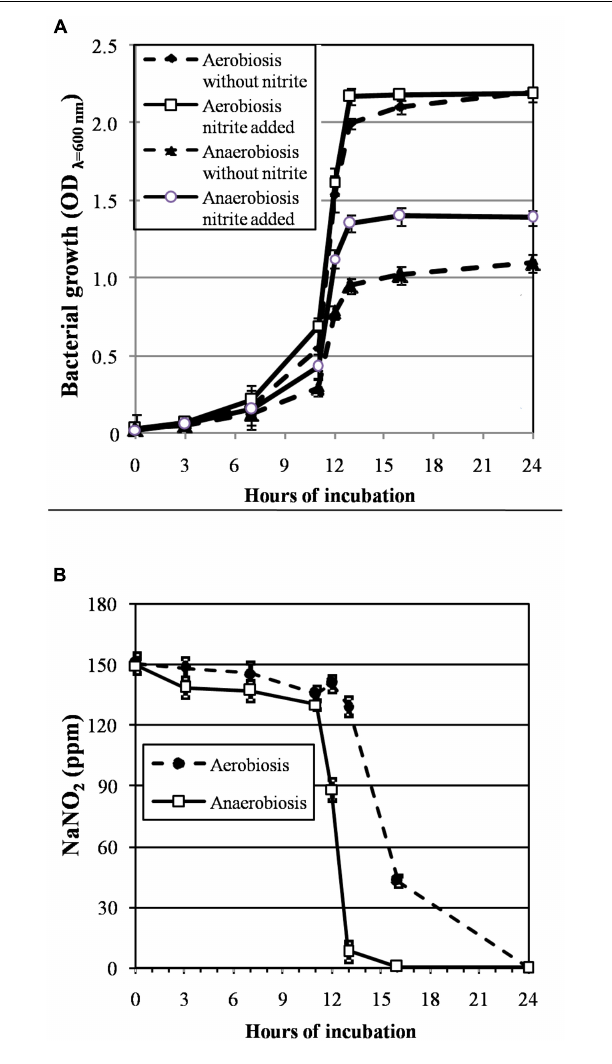
FIGURE 1 | (A) Growth curves (OD 600nm ) of S. xylosus DSM 20266T under aerobic and anaerobic conditions for 24 h in basic medium (BM) containing or not sodium nitrite (150 ppm). Each value represents the average ± standard deviation (bars). Differences among all values higher than 0.244 OD 600nm are considered statistically significant according to post hoc multi-comparison Fisher’s least significant difference test (95% interval confidence). (B) Reduction of nitrite content (ppm NaNO 2 ) in supernatant of S. xylosus DSM 20266T cultures during growth under different conditions. Each value represents the average ± standard deviation (bars).